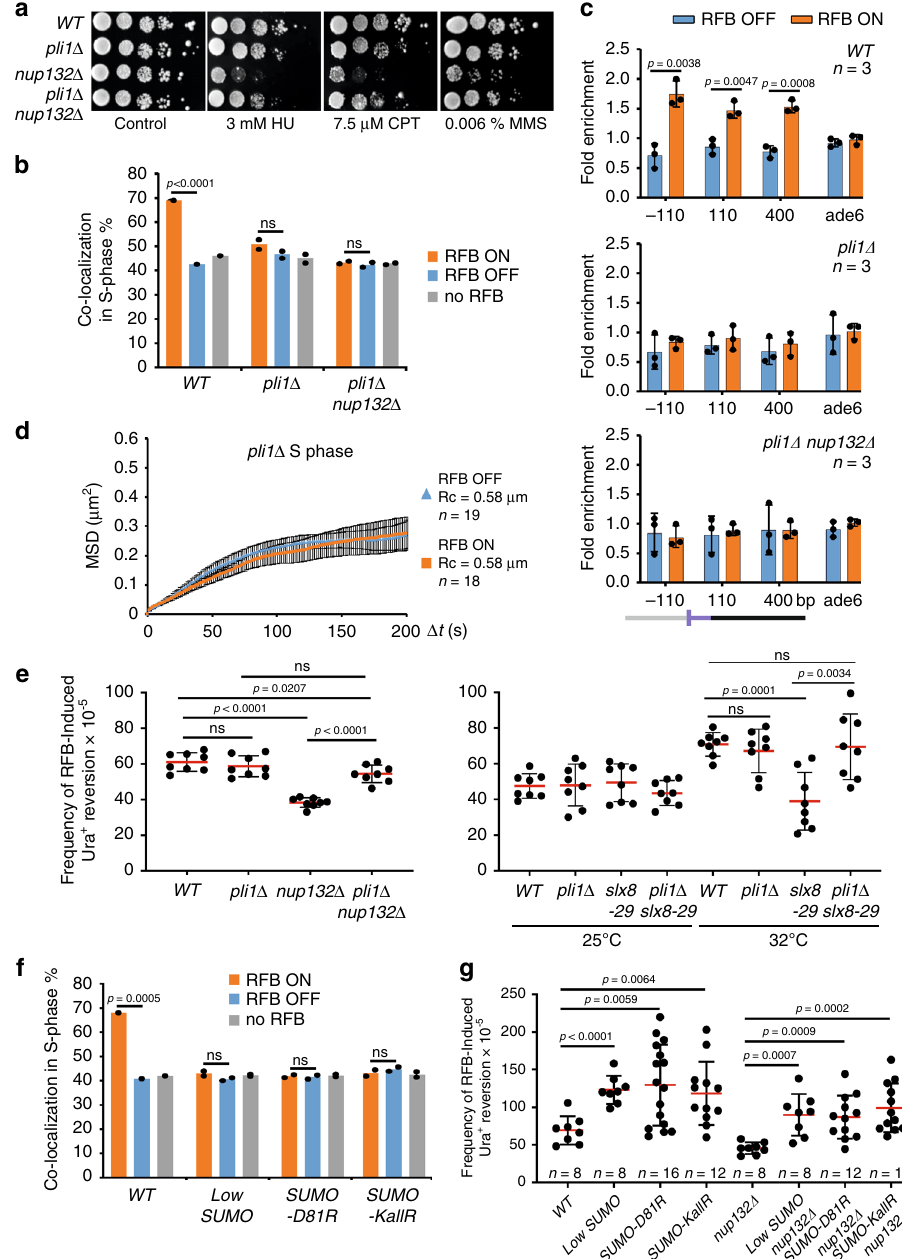
Fig. 5 Pli1-dependent SUMO chain promotes relocation to NPCs but are toxic to RDR. a Sensitivity of strains to indicated genotoxic drugs. Ten-fold serial dilution of exponential cultures were dropped on appropriate plates as described in Fig. 4a. b Co-localization event in S-phase cells in indicated conditions and strains as on Fig. 2a. p value was calculated by Fisher ’ s exact test for OFF and ON groups for each mutant and condition. c Binding of Npp106-GFP to the RFB in indicated strains. Upstream and downstream distances from the RFB are presented in bp. Primers targeting ade6 gene were used as unrelated control locus. Values are mean of three independent biological repeats ± SD. p value was calculated using two-sided t -test. d MSD of the RFB in OFF and ON conditions in S phase cells of pli1 Δ mutant over indicated time interval ( Δ t) calculated for n independent cells, as described on Fig. 1d. Black bars correspond to SEM. e Frequency of RFB-induced Ura + reversion in indicated strains and conditions. Each dot represents one sample from eight independent biological replicate for each strain. Bars indicate mean values ± SD. p value was calculated by two-sided t -test. f Co-localization event in S-phase cells in indicated conditions and strains as in Fig. 2a. p value was calculated by Fisher ’ s exact test for OFF and ON groups for each mutant and condition. g Frequency of RFB-induced Ura + reversion in indicated strains and conditions. Each dot represents one sample from n independent biological replicate for each strain. Bars indicate mean values ± SD. p value was calculated by two-sided t